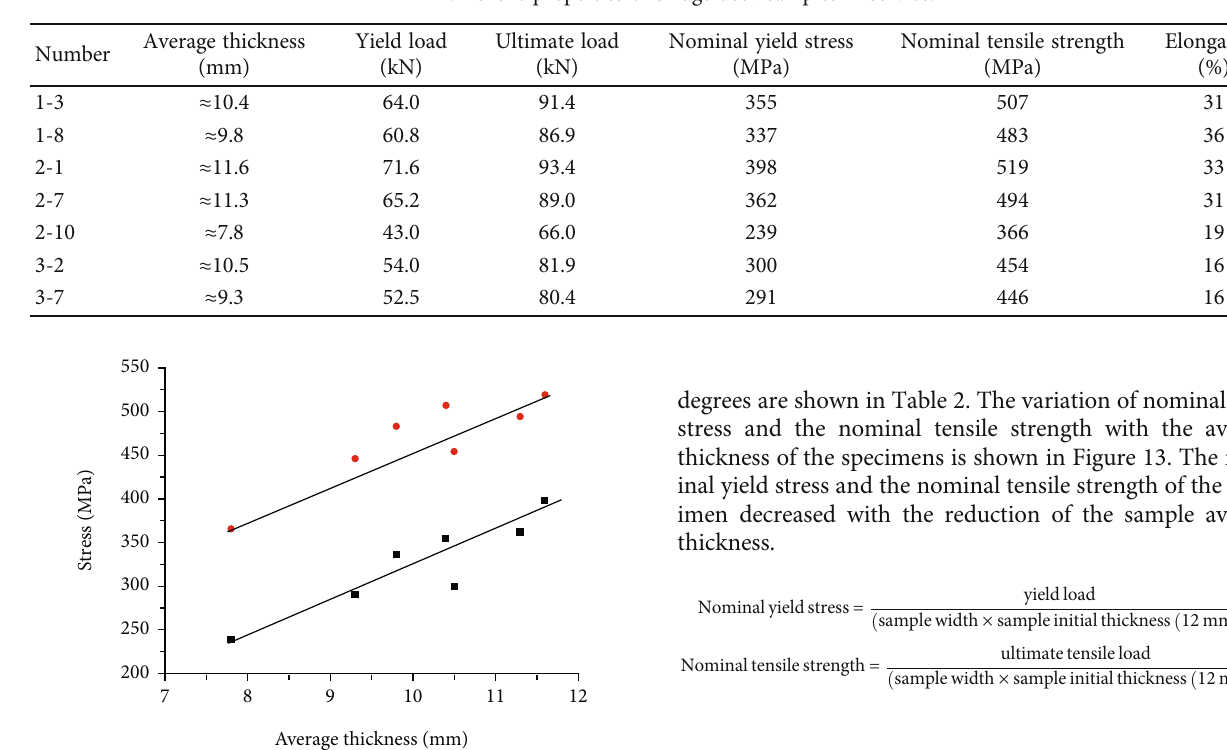
Table 2: Tensile properties of bridge deck samples in service.